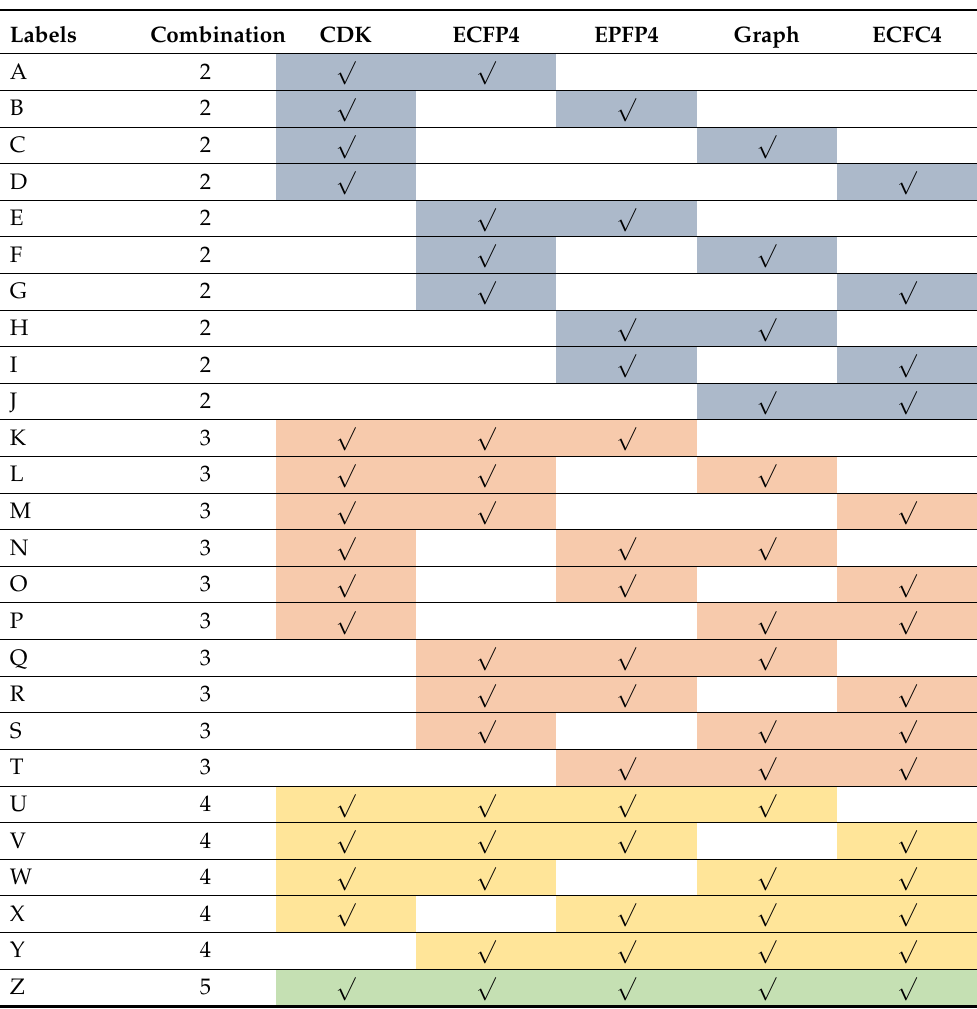
Table 1. Probable combination cases for the five best